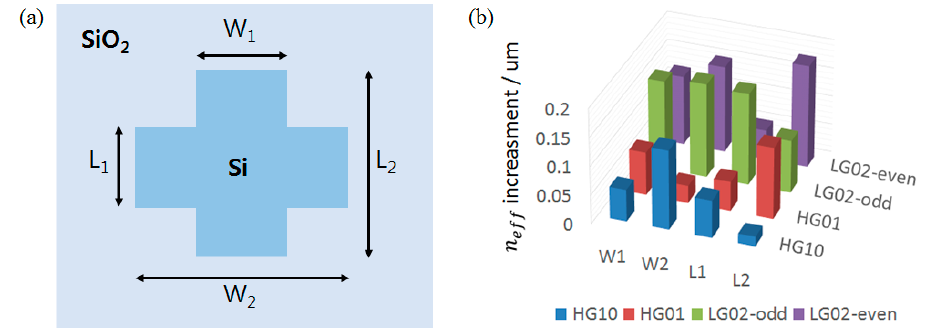
Figure 2. ( a ) Waveguide structure for simultaneously guiding l = ±1 OAM mode and l = ±2 OAM modes; and ( b ) mode effective index dependency on waveguide parameters. Optimal design parameters are W 1 = 1.118 µ m, L 1 = 0.921 µ m, W 2 = 1.626 µ m, and L 2 = 1.504 µ m.